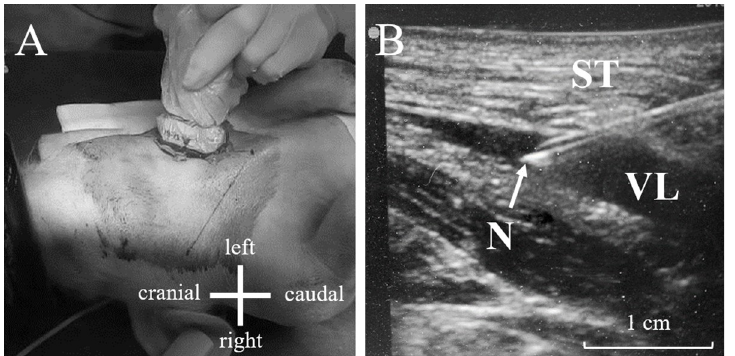
Fig 2. A. Photograph that shows the positioning of the ultrasound transducer on the marked line (expected passage of external jugular vein); B. Visualization of the 21G echogenic needle entering the venous lumen; ST = subcutaneous tissues (muscle); VL = venous lumen; N = echogenic